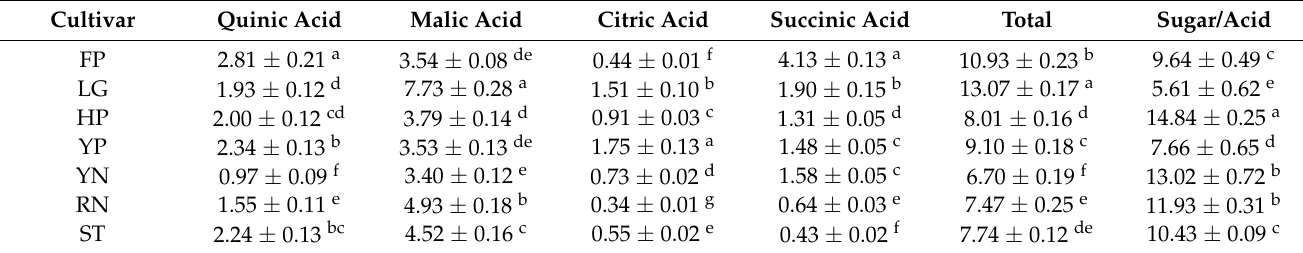
Table 4. Organic acids (mg/g) in flesh of the seven peach